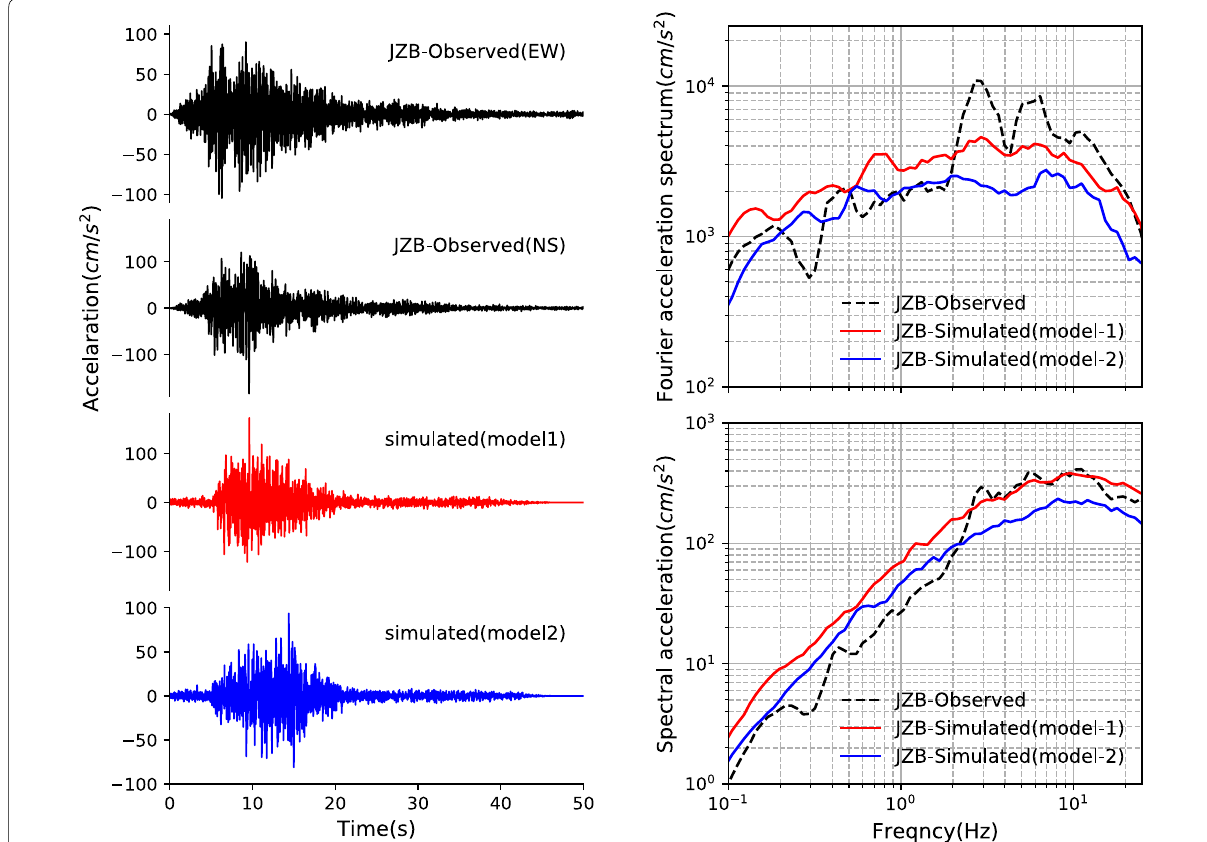
Fig. 4 Comparison of simulated and observed horizontal strong motions at JZB station. The observed (dashed lines) and simulated (solid lines) Fourier amplitude spectra and the response spectra of acceleration are also